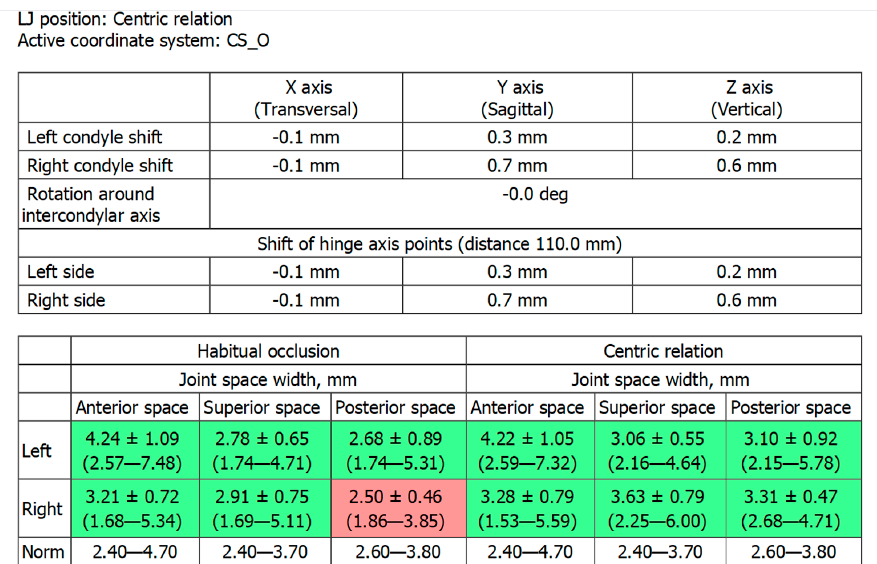
Figure 5. Virtual LJ repositioning. Repositioning of the right mandibular condyle consisted of its slight shift, forward and down, to normalise the intra-articular posterior space width of the right TMJ. It is traced in red colour.